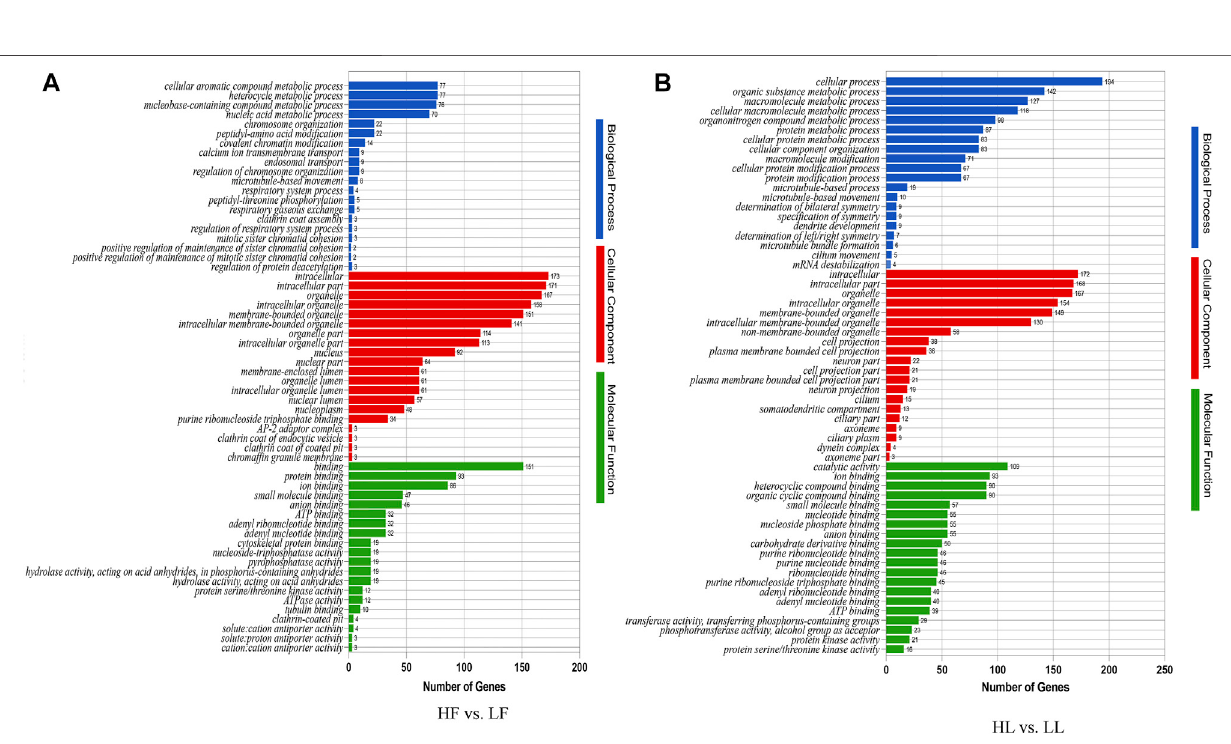
Frontiers in Genetics |